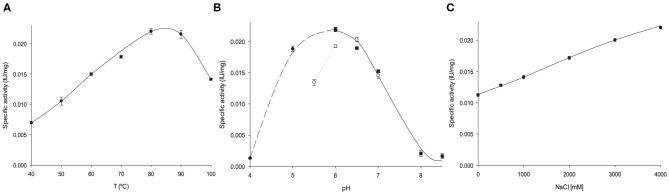
Biochemical characterization of AvNRT activity. (A) Temperature dependence. (B) Effect of pH, (•) sodium citrate 50 mM (pH 4–6), (◦) MES 50 mM (pH 5.5–7), (■) sodium phosphate 50 mM (pH 6–8.5). (C) Effect of ionic strength.